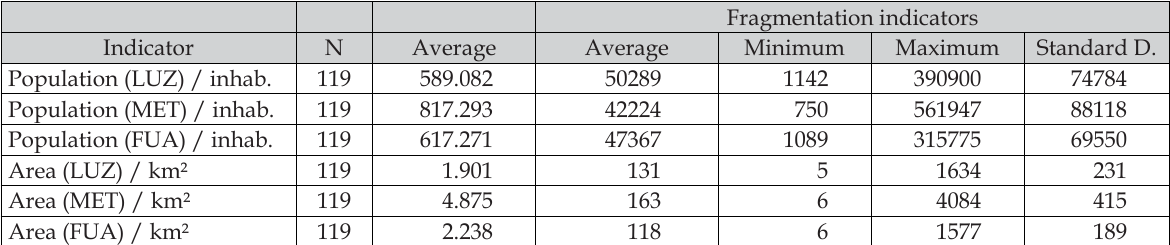
Table 3. Descriptive statistics of fragmentation in LUZes, METs and